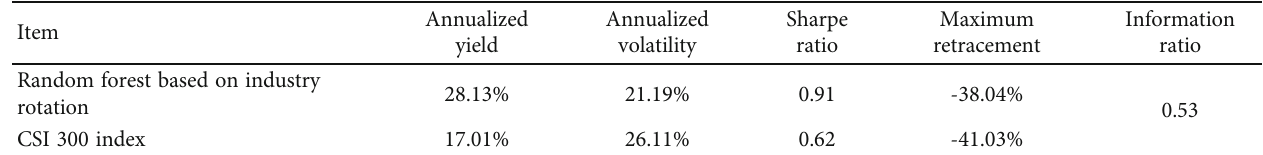
Table 13: Performance evaluation of random forest stock selection